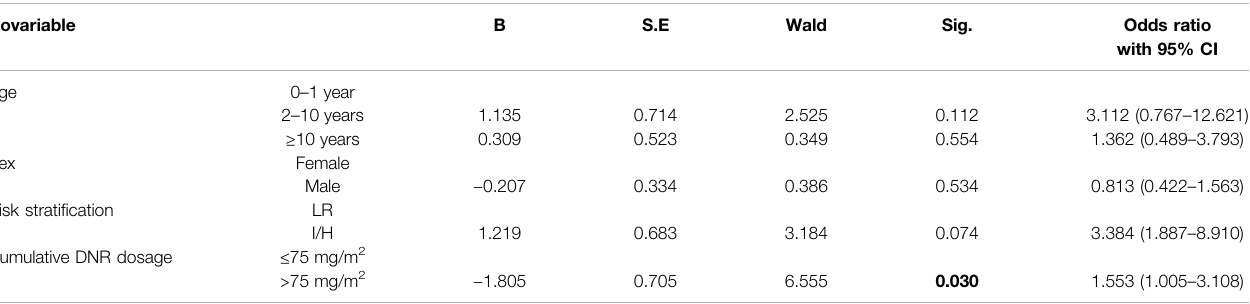
TABLE 3 | Binary logistic regression analysis to identify risk factors associated with cardiac disorders. Covariable B S.E